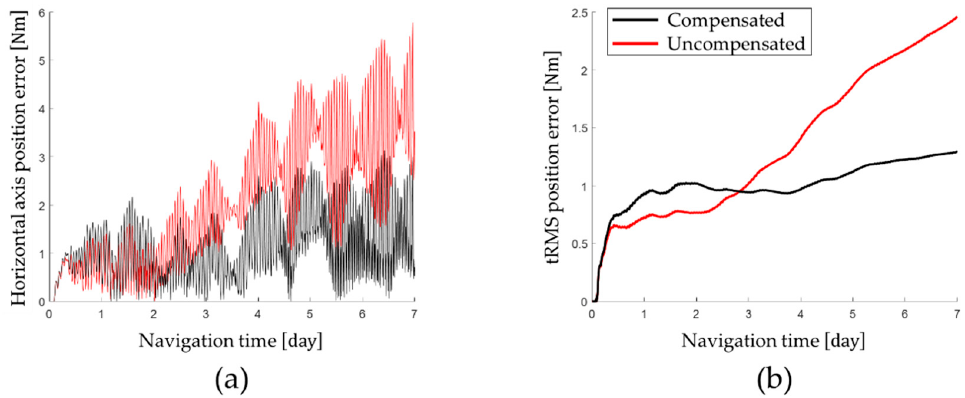
Figure 10. Position error after compensating for gyro bias transition: ( a ) latitude error and longitude error; ( b ) horizontal axis position error and tRMS position error; ( b ) horizontal axis position error and tRMS position error. Table 5. Navigation performance of the long-term static state test.